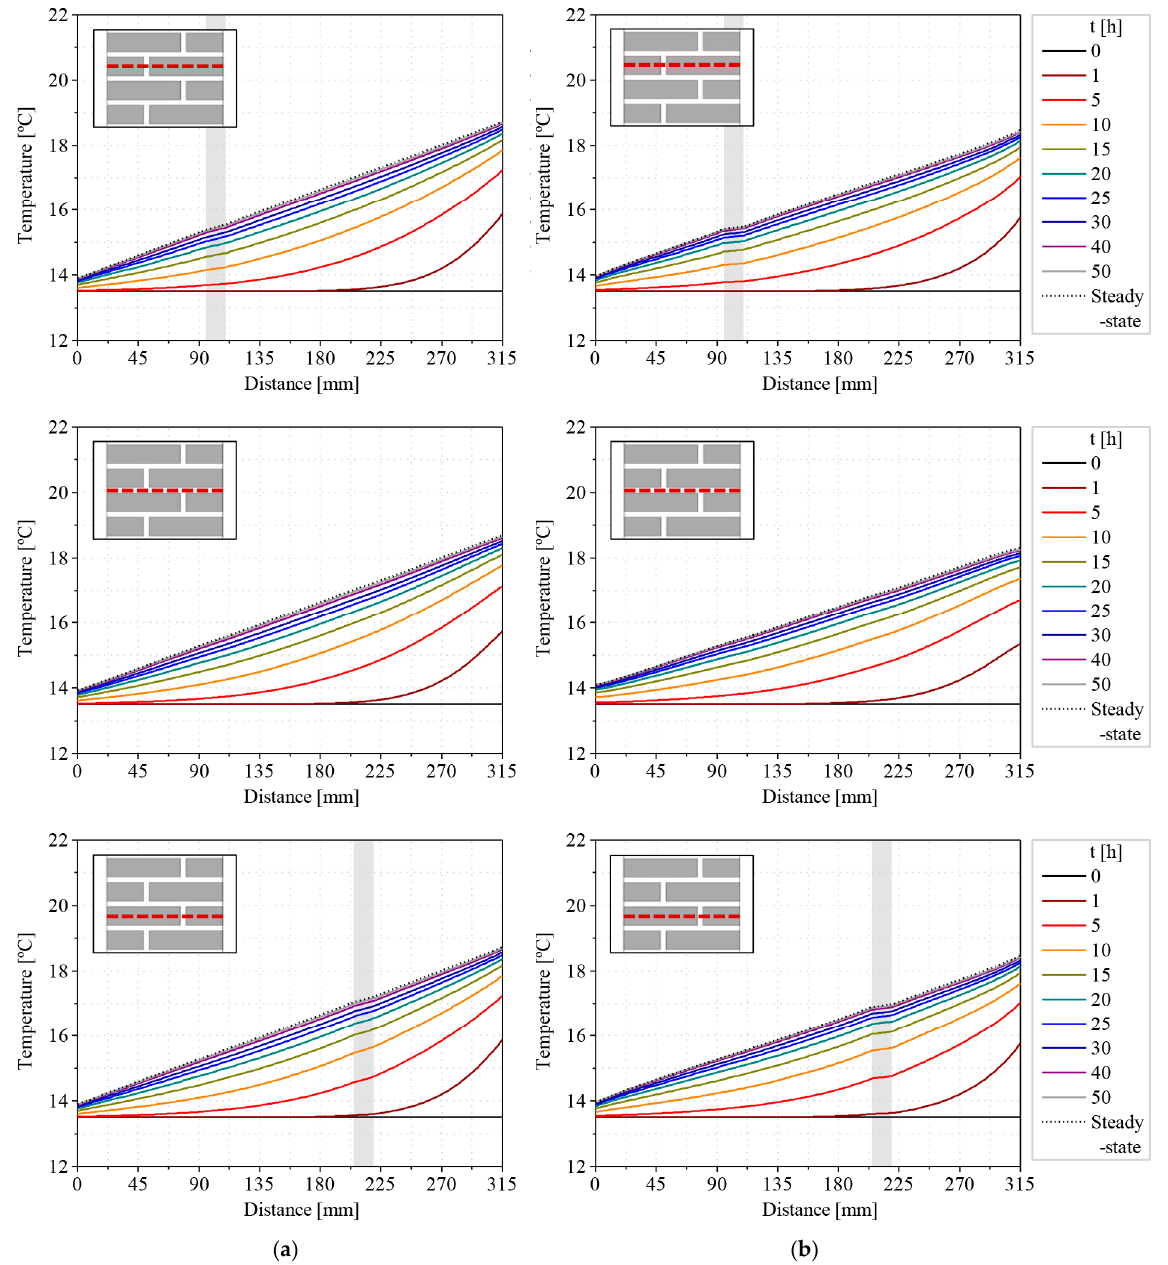
Figure 5. Time-dependent analysis (TD1). Temperature evolution across the studied three-wythe brick masonry wall: ( a ) joints with natural hydraulic lime mortar (LM); ( b ) joints with cement mortar (CM). Lines A–A’ ( top ), B–B’ ( middle ), and C–C’ ( bottom ). There are some differences between the wall with lime mortar (LM) and the one with cement mortar (CM). On one hand, the temperature evolution is faster for the CM case. In other words, the wall with cement mortar requires less time to reach thermal equilibrium.